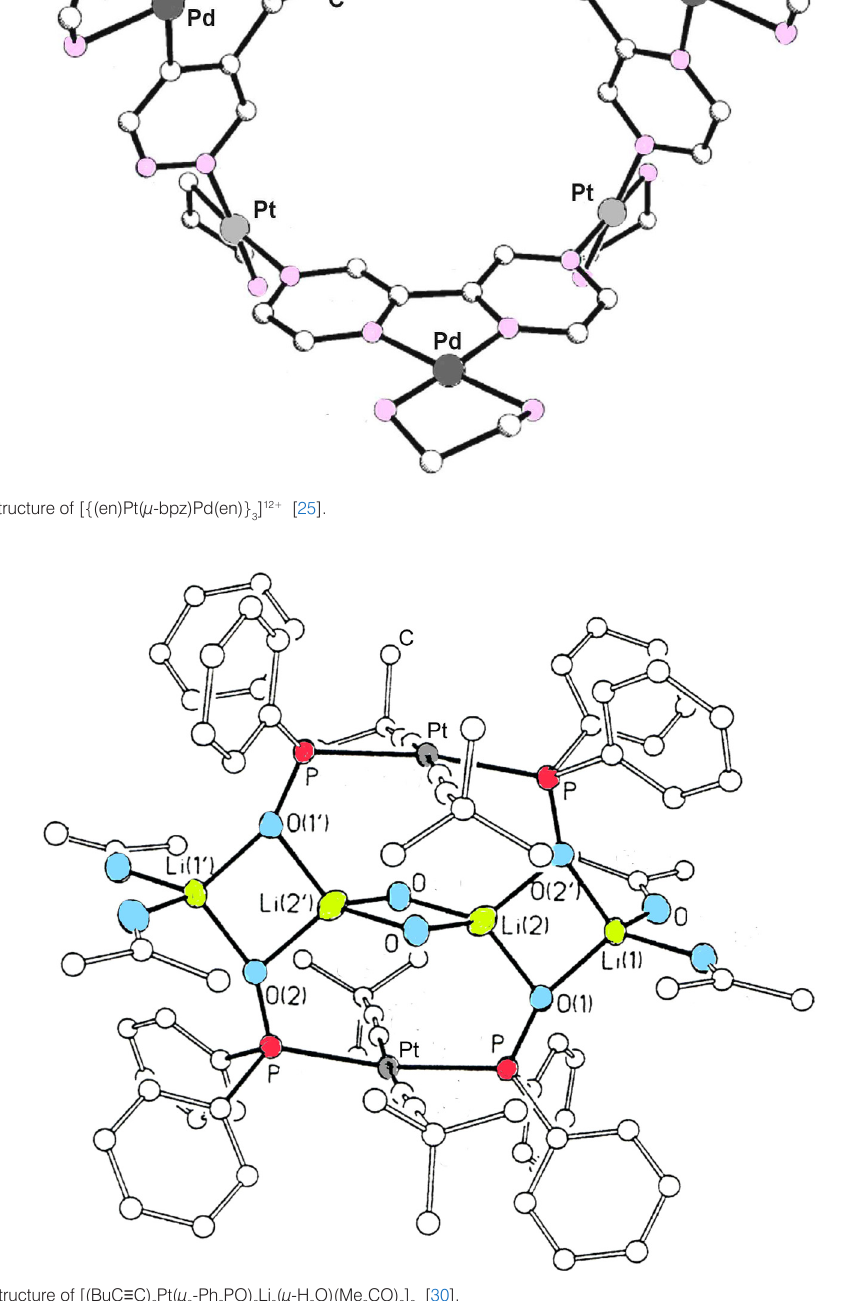
Pt(µ -Ph PO) Li (µ-H O)(Me 2 3 2 2 2 2